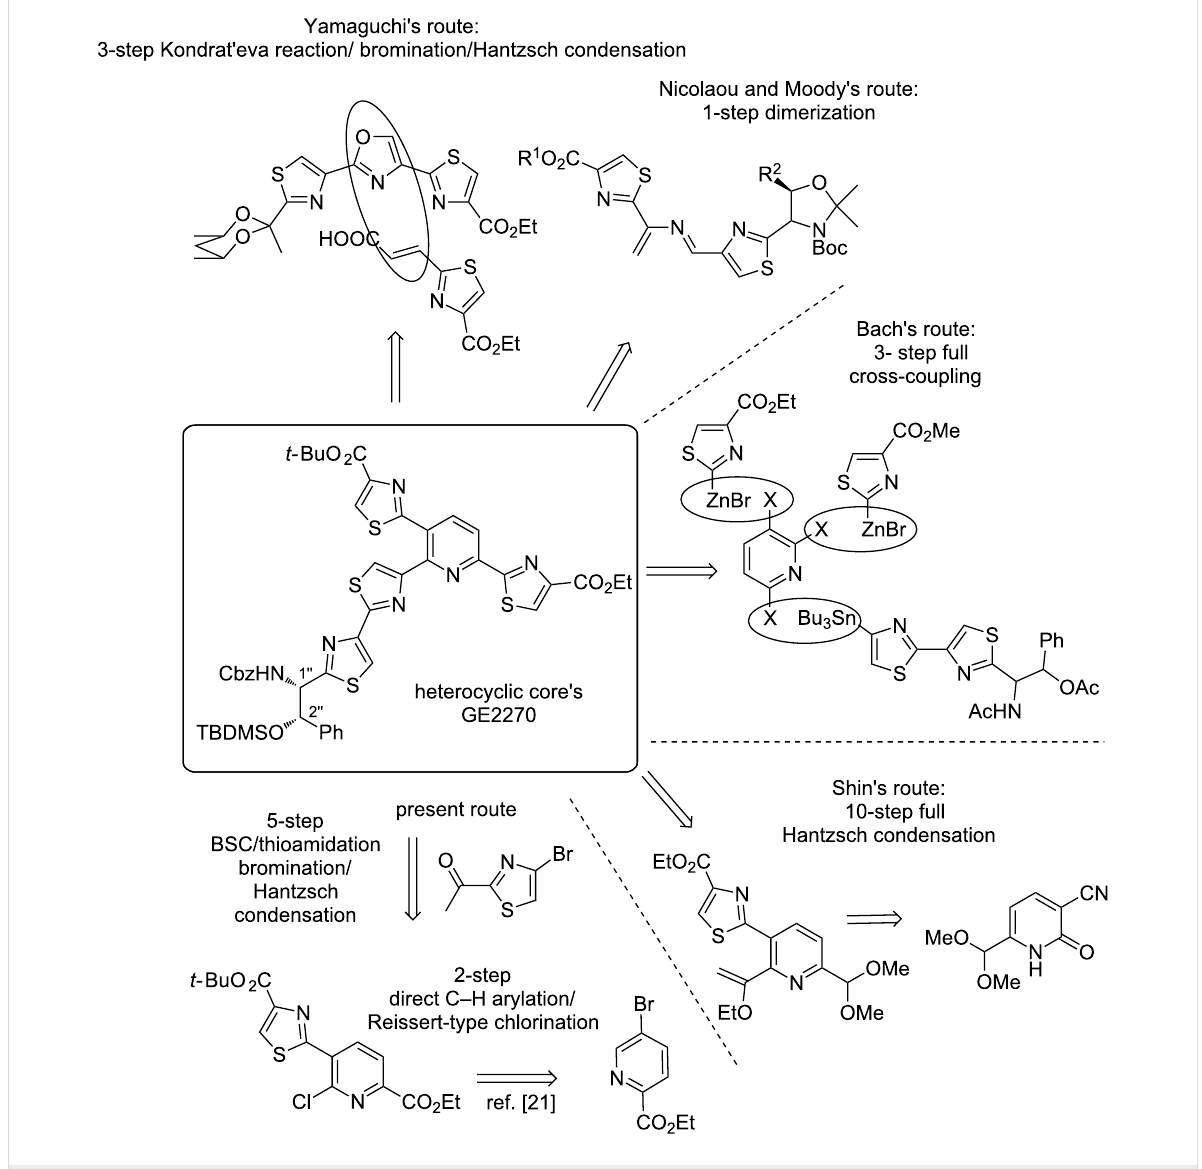
Figure 1: Main synthetic strategies towards heterocyclic cores of D-series GE2270 and our present